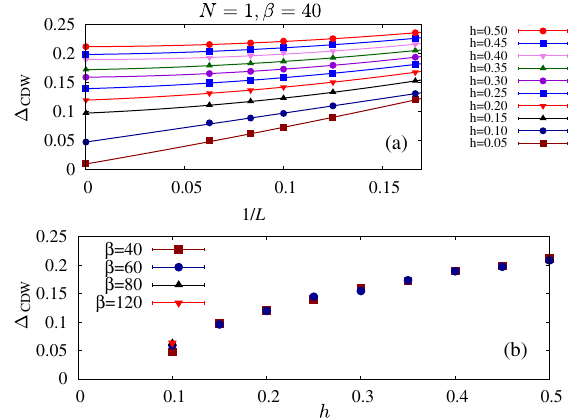
FIG. 5. (a) Electric field and (b) magnetic flux for the N ¼ 1 model as a function of the transverse field. After taking into account the strong finite temperature and size effects in the small h limit, the data are consistent with a smooth behavior.